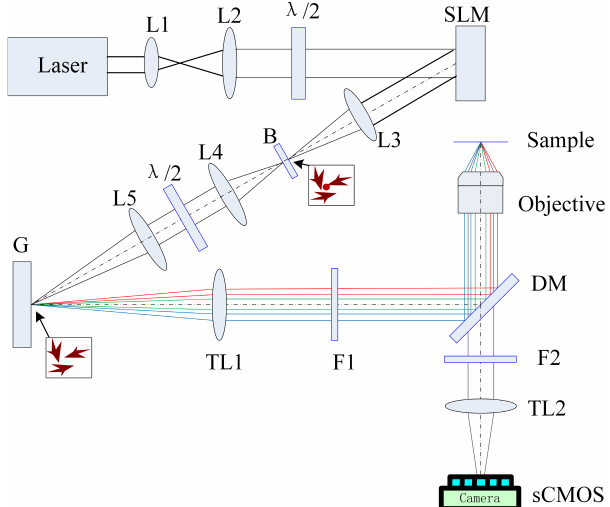
Fig. 1. Schematic of our SMTM-MPM based on the combi- nation of a SLM and grating. The grating, TL1 and the ob- jective lens comprise a temporal focusing system. The SLM on the back focal plane of Fourier lens L3 modulates the input fs beam to generate the required excitation pattern matching the target sample of interest on the front focal plane of L3. The zero-order light is blocked by a blocker. The polarization of the fs beam is tuned by a (cid:3)= 2 wave plate. Laser: a model-locked laser that generates an fs beam; L1 to 5: lens; B: blocker; TL1 and TL2: tube lens; F: ¯lter; DM: dichroic mirror; Camera: sCMOS